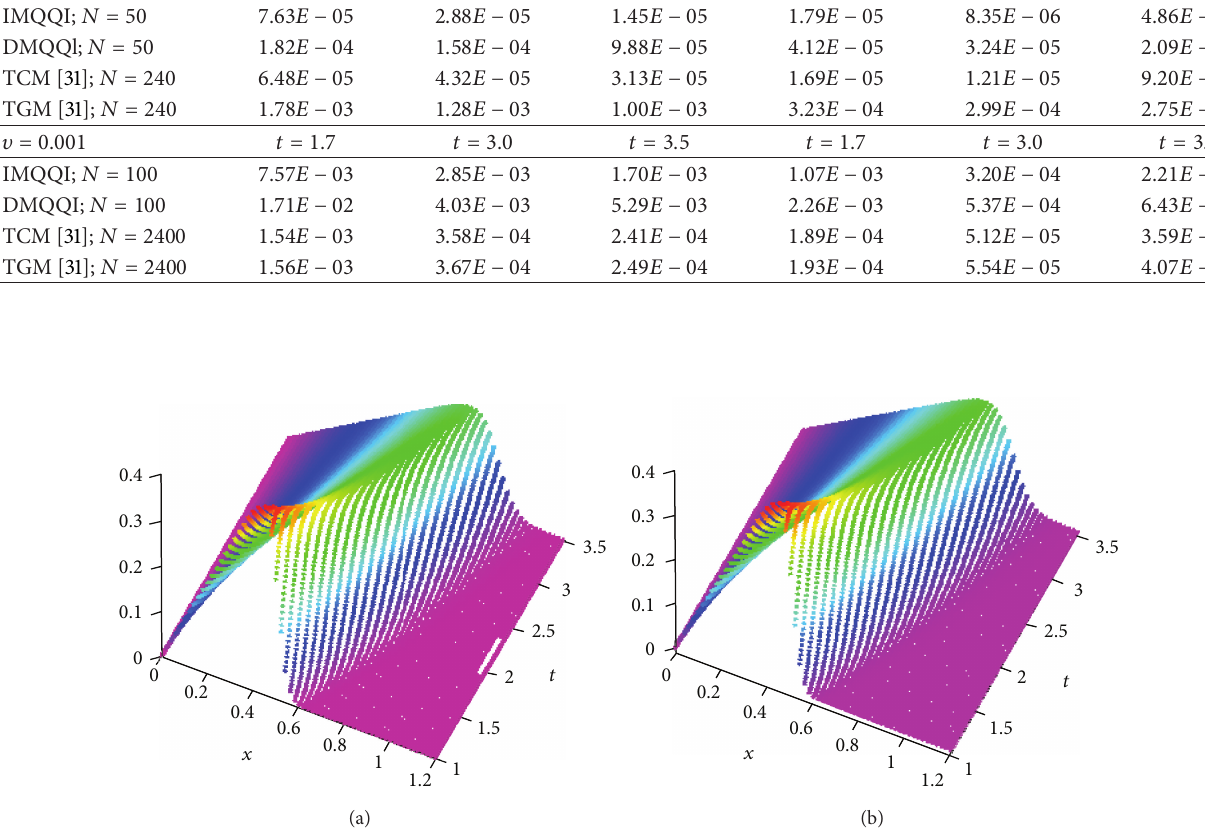
Figure 3: The space-time graph of the estimated solution of Burgers’ equation by using IMQQI (a) and DMQQI (b) for 𝑥 ∈ [0,1.2] and 𝑡 ∈ [1, 3.5] of Experiment 2.